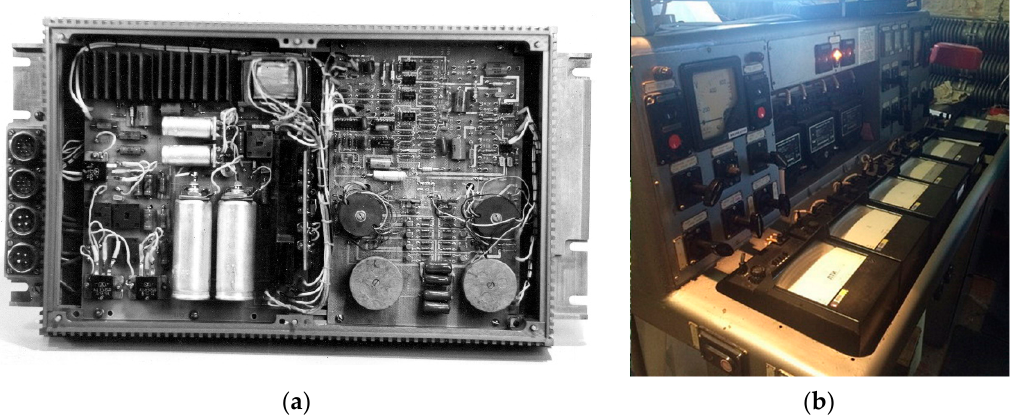
Figure 3. Photos of equipment for experiment. ( a ) Prototype of BUTV (B-3801) thyristor exciter for mining excavators; ( b ) The testing stand in Karpinsky Electric Machine Building Plant.